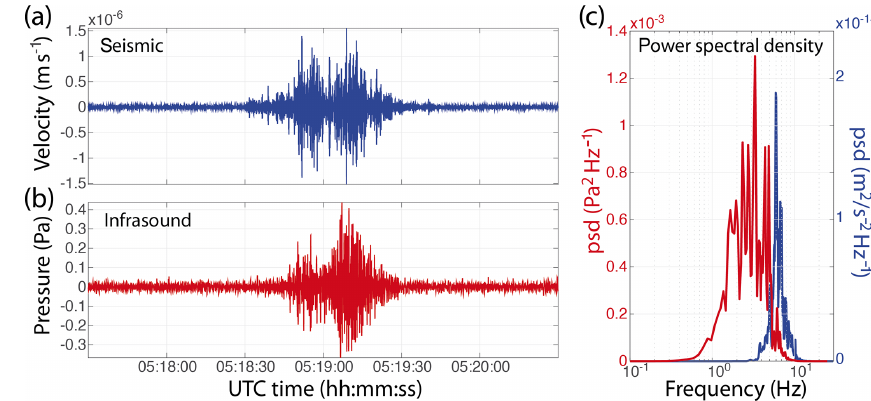
Figure 4. Seismic (a) and infrasound (b) signals of the avalanche that occurred on 5 February 2016 recorded by sensor s3 of the seismic array and by sensor m3 of the infrasound array (Fig. 1b and c). (c) Power spectral density (psd) of the seismic (blue) and infrasound signal